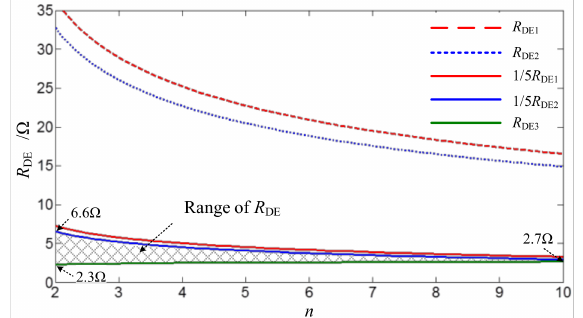
Figure 7. Range of resistor R DE with different n